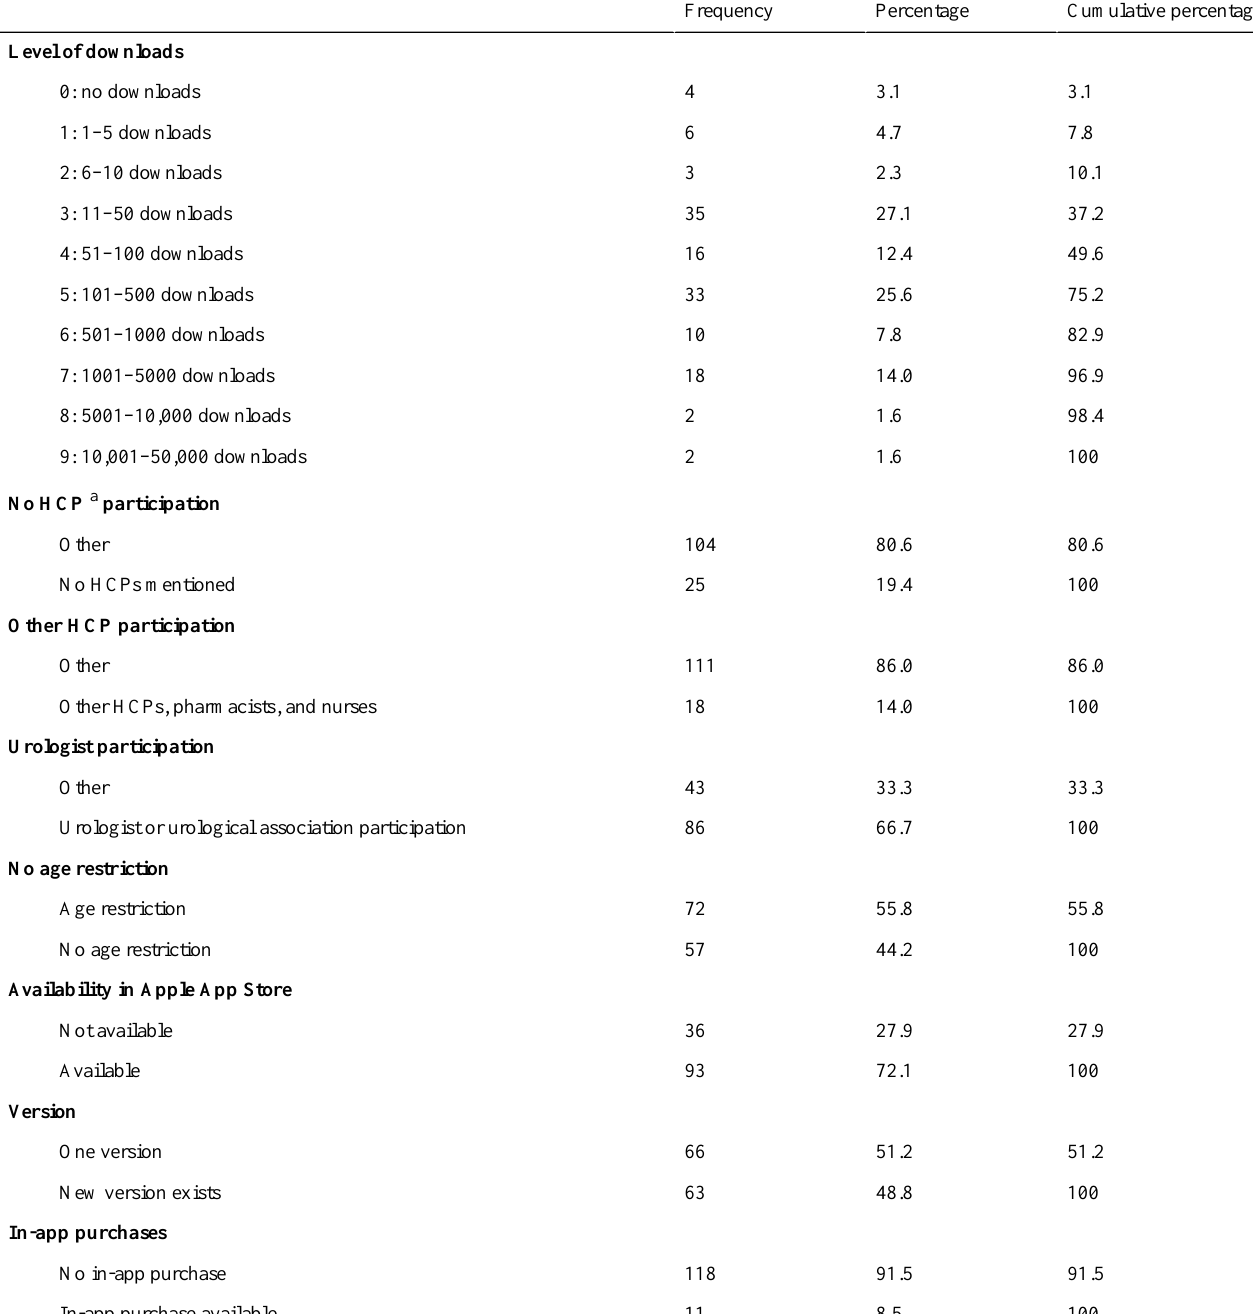
Table 3. Frequencies for the categorical and binary variables.